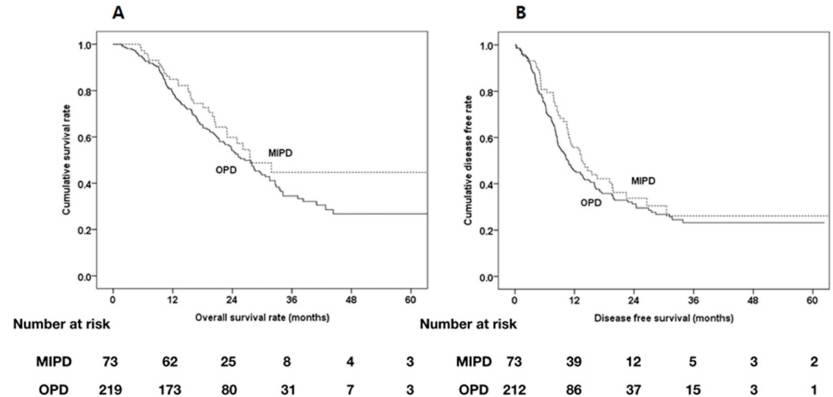
Figure 4. Kaplan-Meier survival curves of MIPD group ( n = 73) and OPD group ( n = 219) after propensity score matching. (A) Median OS and estimated 1-, 2-, and 5-year OS were 27.6 months and 84.9%, 59.8%, and 44.7% in the MIPD group, and 26.5 months, 79.4%, 54.0%, and 26.7% in the OPD group, respectively ( p = 0.143). (B) Median DFS and estimated 1-, 2-, and 5-year DFS were 13.7 months and 55.7%, 33.8%, and 26.1% in the MIPD group and 10.7 months and 45.5%, 31.3%, and 23.2% in the ODP group, respectively ( p = 0.278).